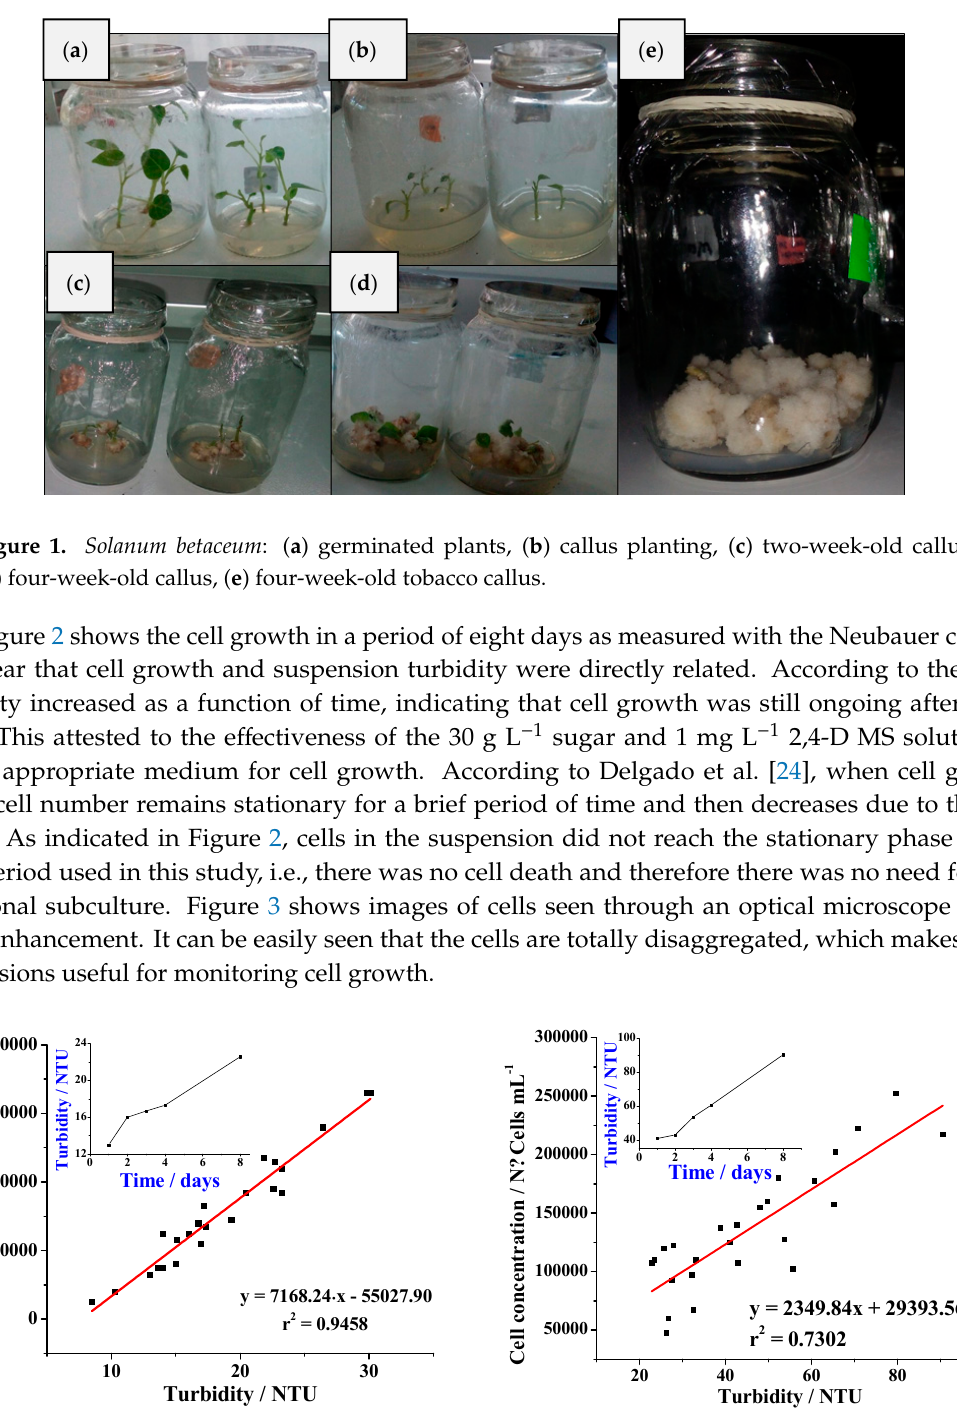
Figure 1. Solanum betaceum : ( a ) germinated plants, (b ) callus planting, ( c ) two-week-old callus, ( d ) four-week-old callus, ( e ) four-week-old tobacco callus. Table 1. (*). Percentage of embryogenic callus formation of Solanum betaceum .